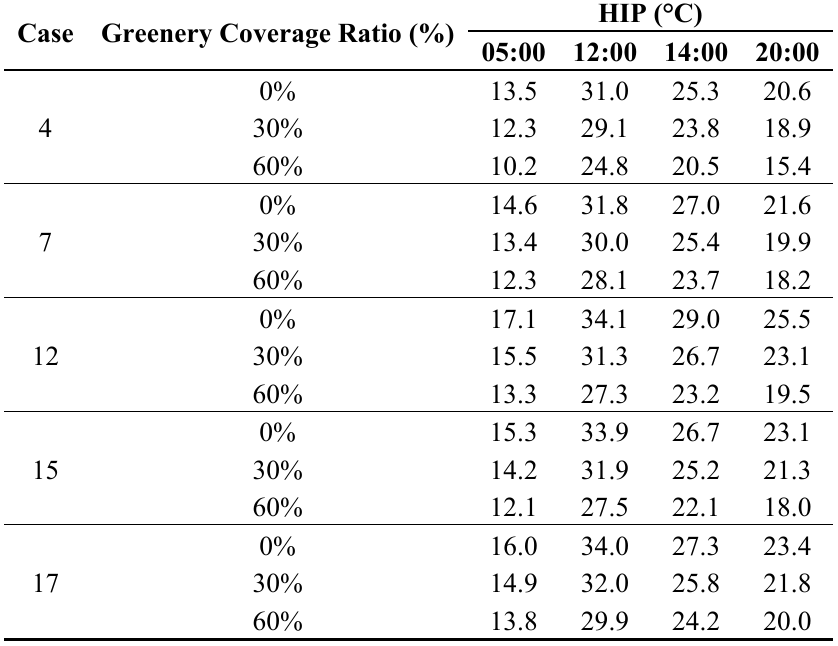
Figure 8. MRT results according to changes in the greenery coverage ratio. Table 6. Heat Island Potential (HIP) by greenery coverage